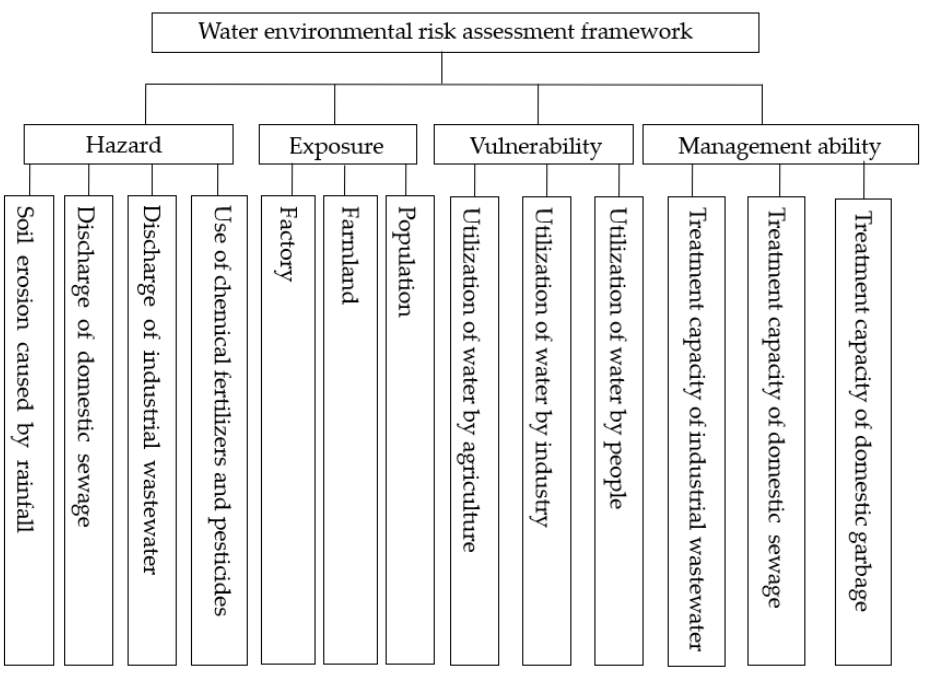
Figure 2. The water environmental risk assessment framework.